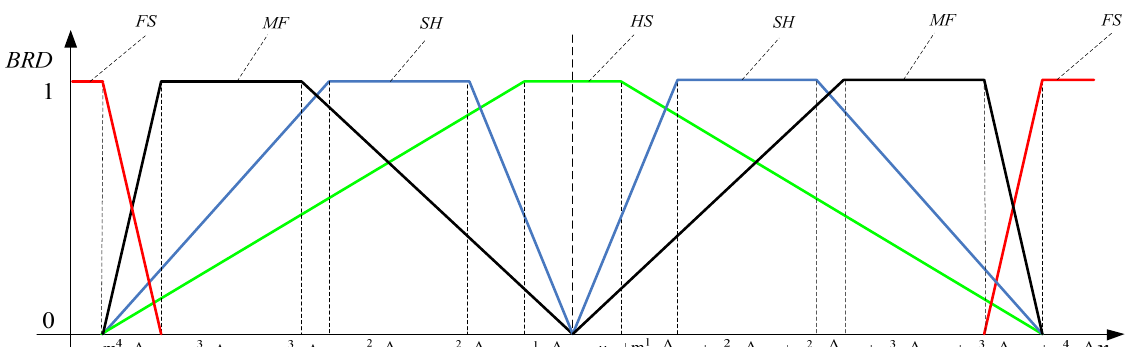
Figure 6. Relationship between BRD and measured value x